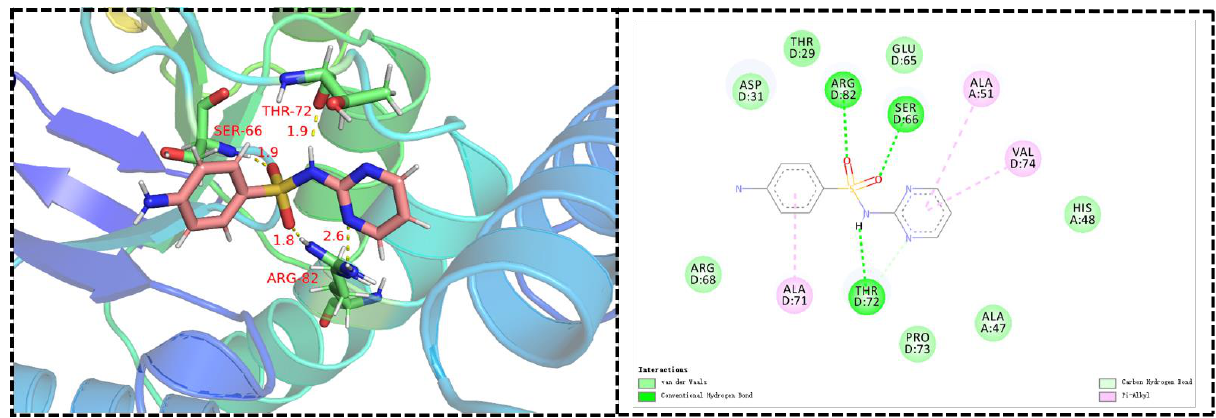
Figure 5. Predicted binding mode and interactions. Molecular docking of sulfadiazine with DHPS. (PDB: 6DAY).